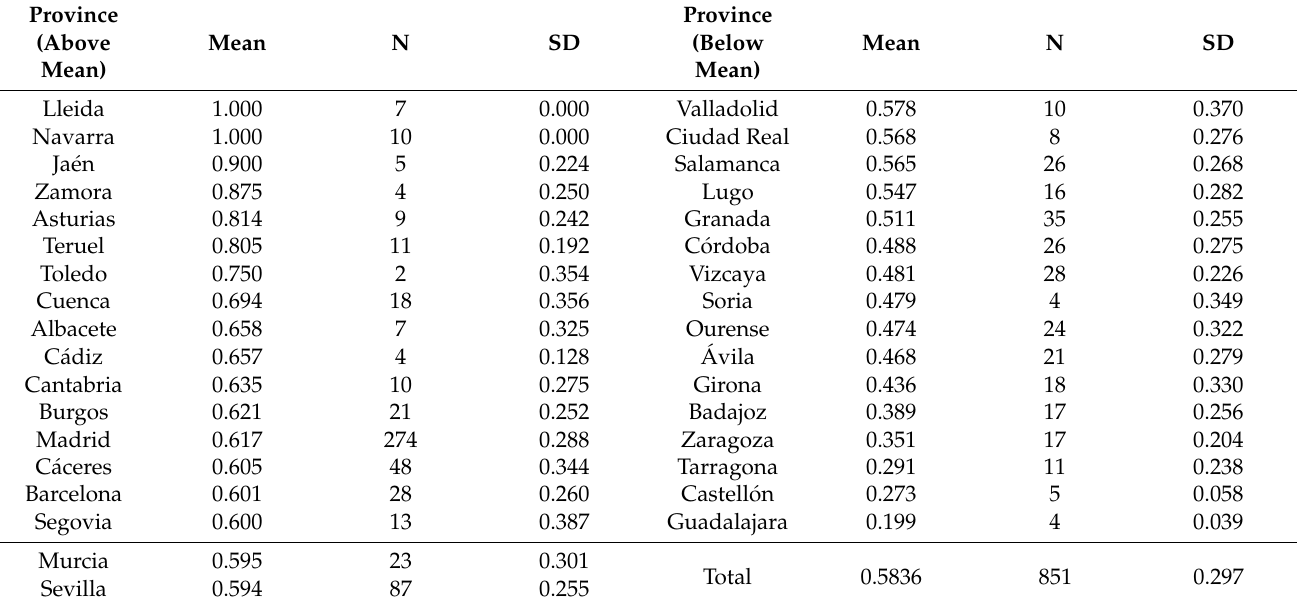
Table 7. Efficiency results by province in cultural tourism